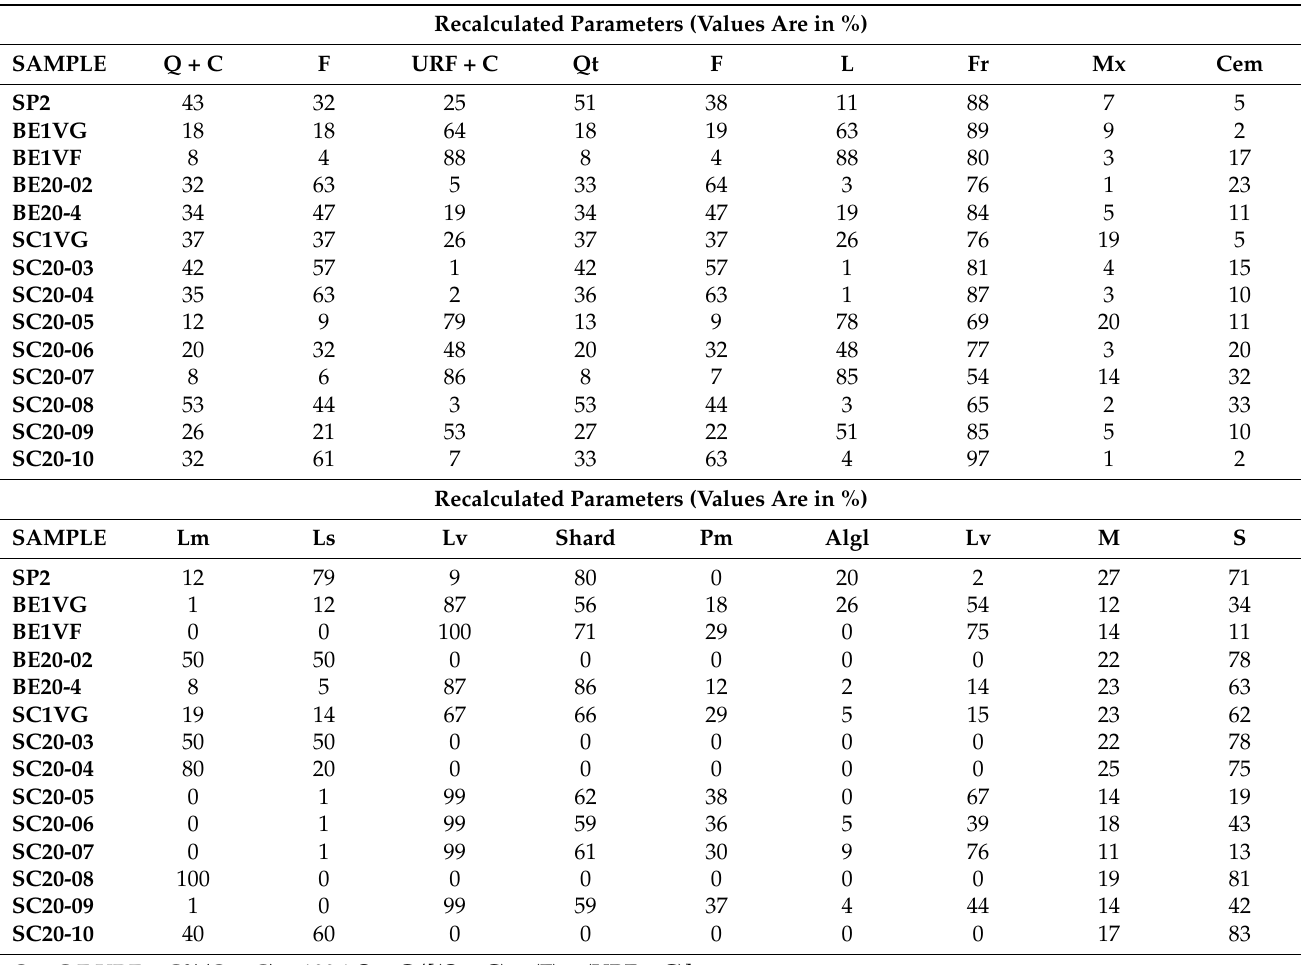
Table 2. Recalculated